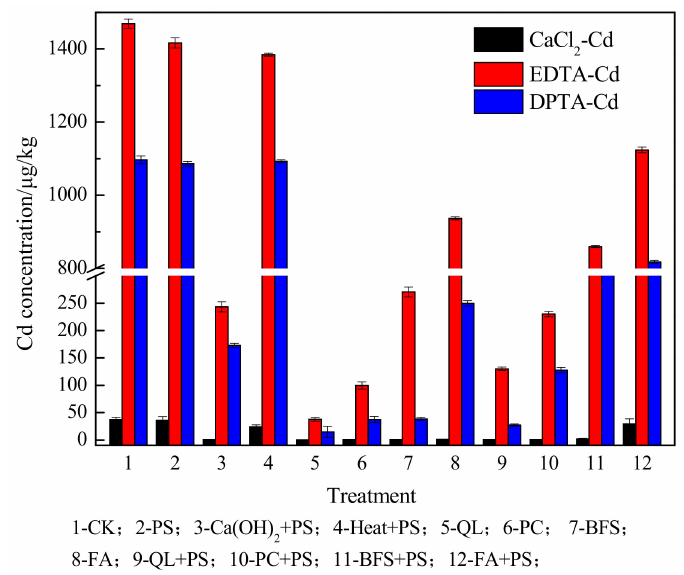
Figure 4. Effect of different treatments on the bioavailable Cd content in soil co-contaminated with aniline and Cd. See Table S3 for the treatment abbreviations. No amendments added (CK); Persulfate (PS); Quick lime (QL), Portland cement (PC), blast-furnace slag (BFS), and fly ash